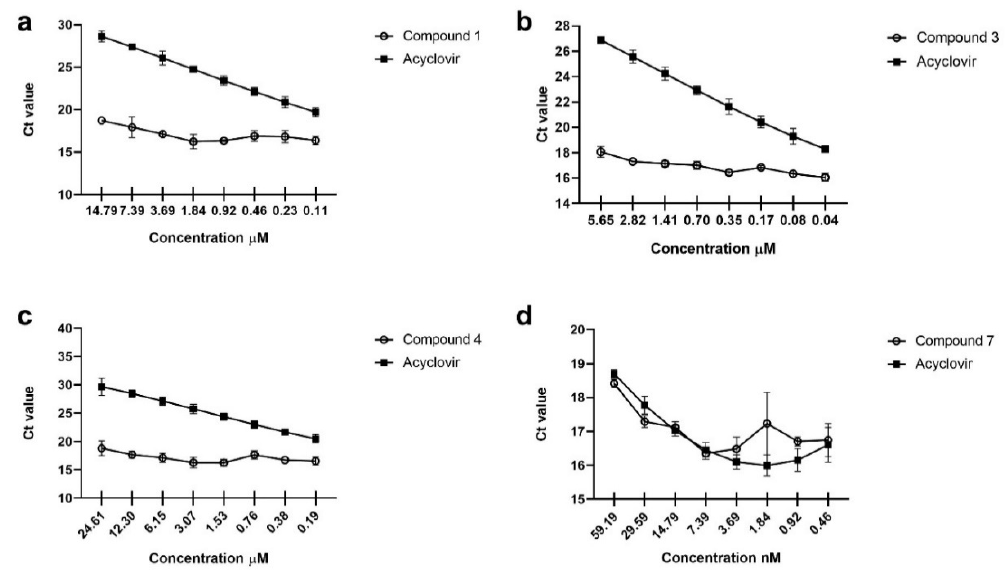
Figure 2. Antiviral activity of compounds. Vero cells were infected with 0.01 MOI HSV-2; after 1 h of incubation, the cells were washed and cultured with a two-fold serial dilution compound containing a medium. After a 24 h incubation period, qRT-PCR measurement using HSV-2 specific primers was carried out to check the antiviral effect of 3 β ,7 β -dihydroxy-24-methylenelanosta-8-ene-11-one ( 1 ) ( a ), euphorbol-7-one ( 3 ) ( b ), deightonin ( 4 ) ( c ), and scoparon ( 7 ) ( d ). Acyclovir was used as a positive antiviral substance.